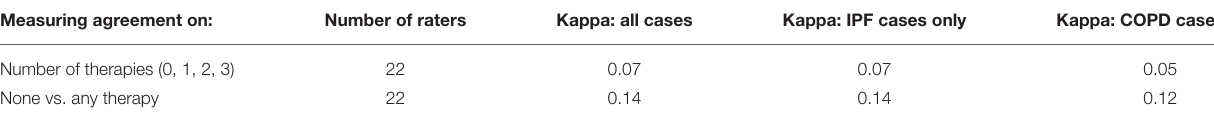
TABLE 5 | Fleiss’ kappa for survey respondents who identified as cardiologists and completed the entire survey ( n = 22).